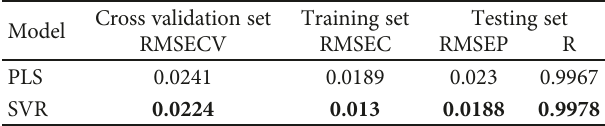
Figure 7: Performance of SVR model. (a) Carbendazim and polyethylene mixture. (b) Carbendazim and rice powder mixture. Table 3: Performance of PLS and SVR in carbendazim and polyethylene mixture.